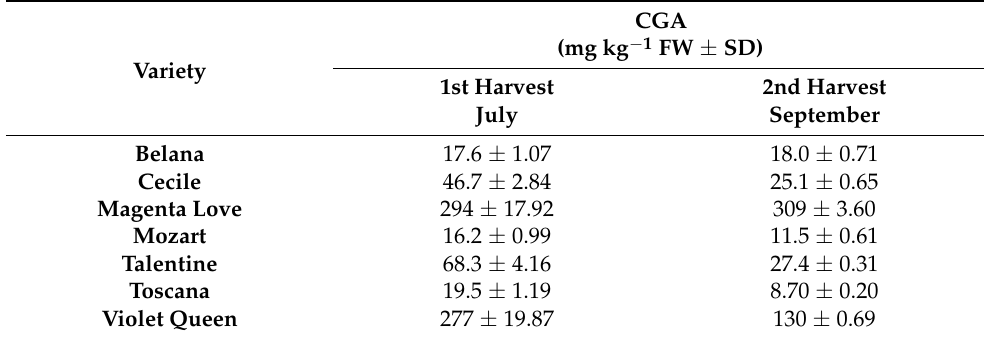
Table 4. The content of chlorogenic acid in seven potato varieties depending on variety and harvest- ing